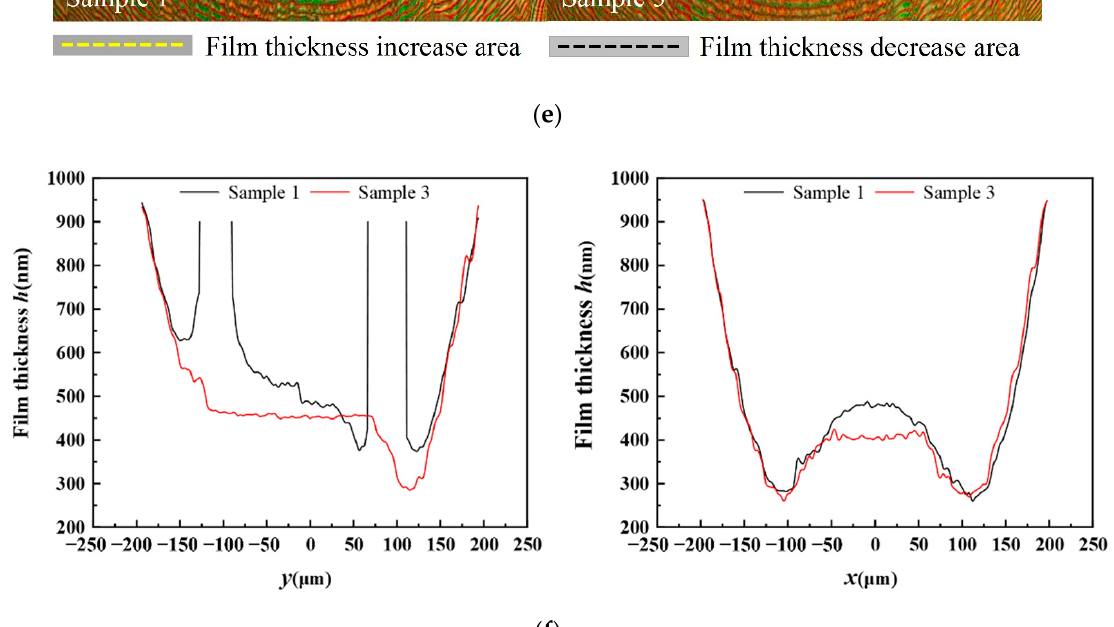
Figure 5. Film thickness distribution and profile of sample 1 and sample 3 along the x and y axes (load = 16.7 N): ( a ) distribution of film thickness—32 mm/s; ( b ) film thickness profile along x and y directions—32 mm/s; ( c ) distribution of film thickness—256 mm/s; ( d ) film thickness profile along x and y directions—256 mm/s; ( e ) distribution of film thickness—512 mm/s; and ( f ) film thickness profile along x and y directions—512 mm/s.